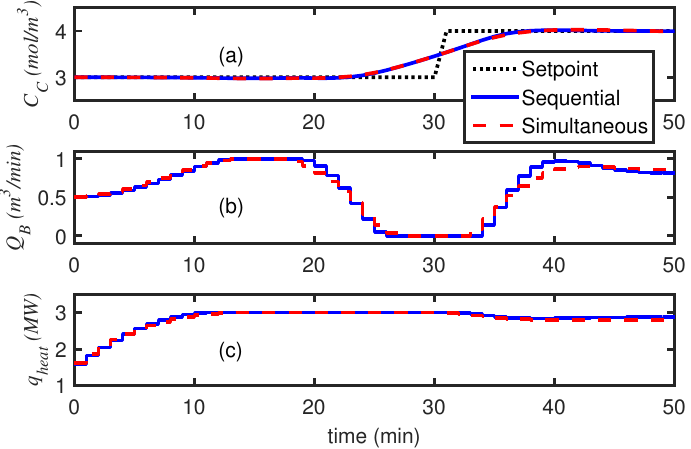
Figure 15. Results from the CSTR with surge tank nonlinear MPC problem showing the solution from the sequential method (blue solid line) with the simultaneous method (red dashed line), where C C is the controlled variable with a setpoint change from 3 to 4 mol/m 3 (a), Q B and q heat are manipulated variables subject to a zero-order